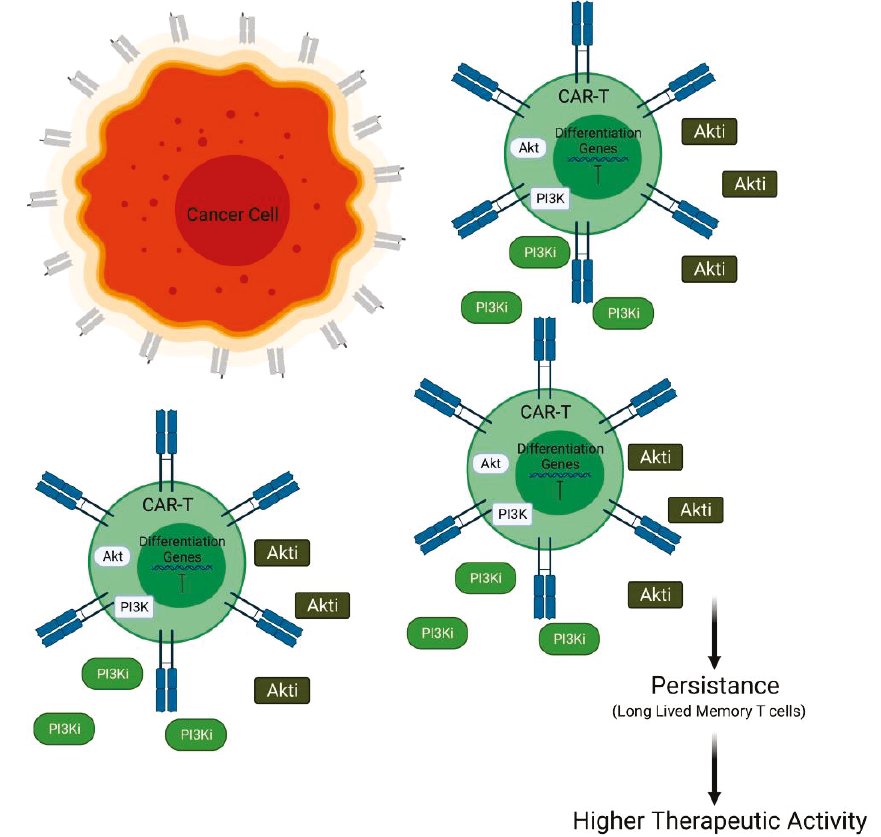
Figure 3. PI3K/Akt inactivation combined with CAR T cell therapy. Inhibition of PI3K or Akt is able to prolong the persistence of CAR T cell blocking the differentiation versus short memory T cells and promoting long-lived memory T cells (Created with BioRender.com: agreement number RXM22NUG34R).